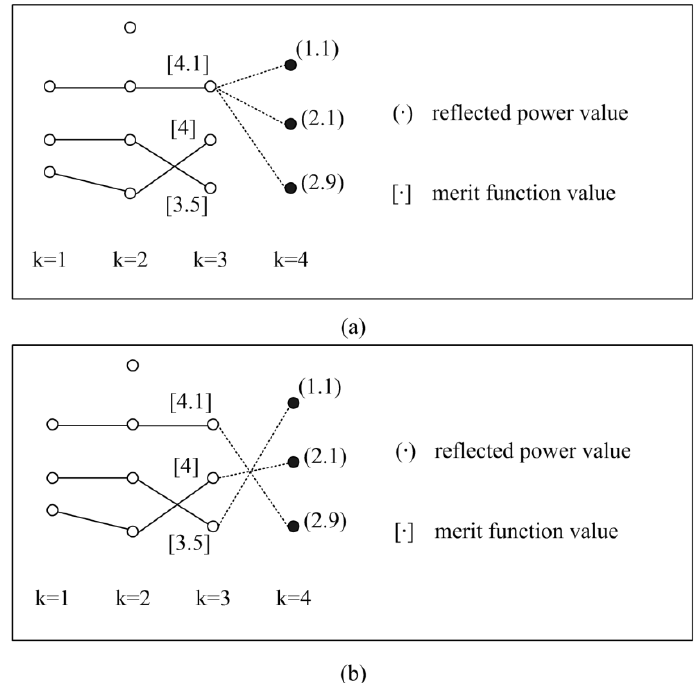
Figure 3. An example ( a ) After Step 2 (track separation exists); ( b ) After Step 3 (the constraint is